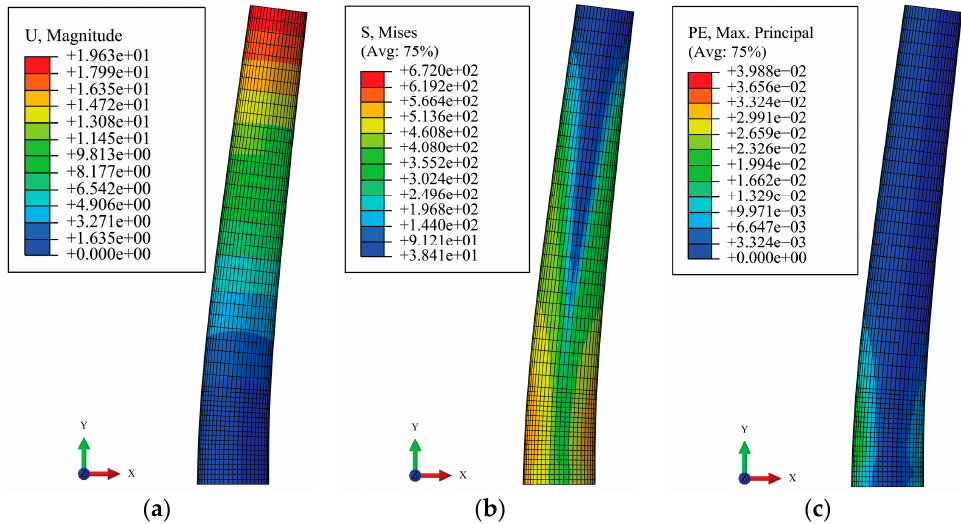
Figure 14. The finite element method analysis results for model C1: ( a ) total deformation; ( b ) von Mises stress; ( c ) maximum principal plastic strain.